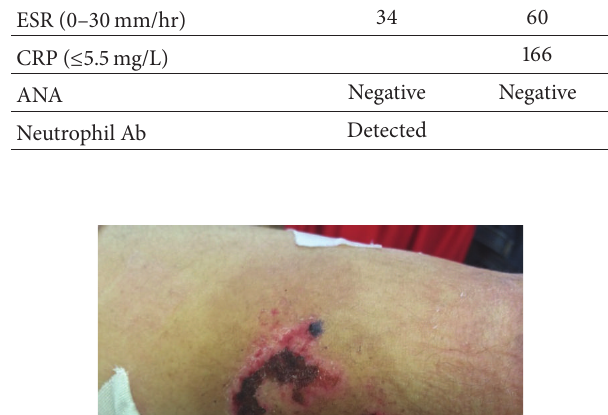
Figure 2: Thrombotic vasculopathy. High magnification showing occluded vessels with intraluminal fibrin and platelet thrombi (mag- nification 400x, H&E